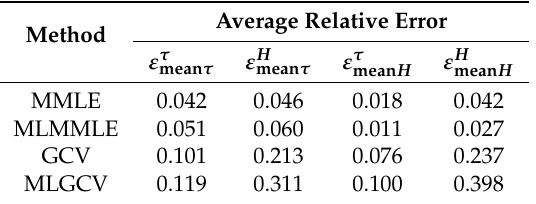
Table 4. Average relative errors for the results plotted in Figure 6.